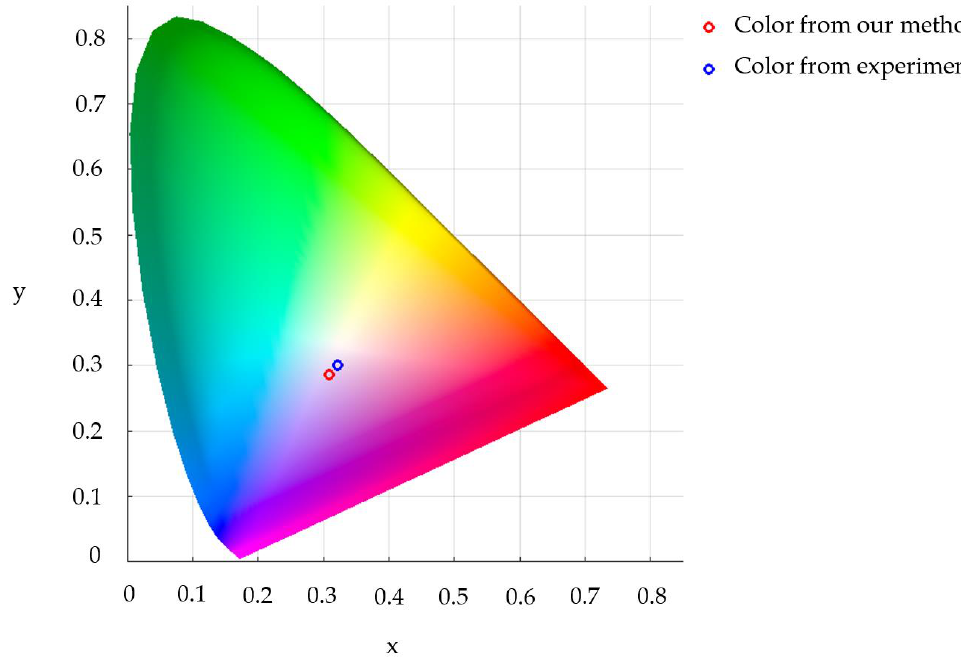
Figure 13. The CIE chromaticity diagram with mapping comparison from our proposed method and the measured color of photograph at laser intensity 60 J/cm 2 from [38].